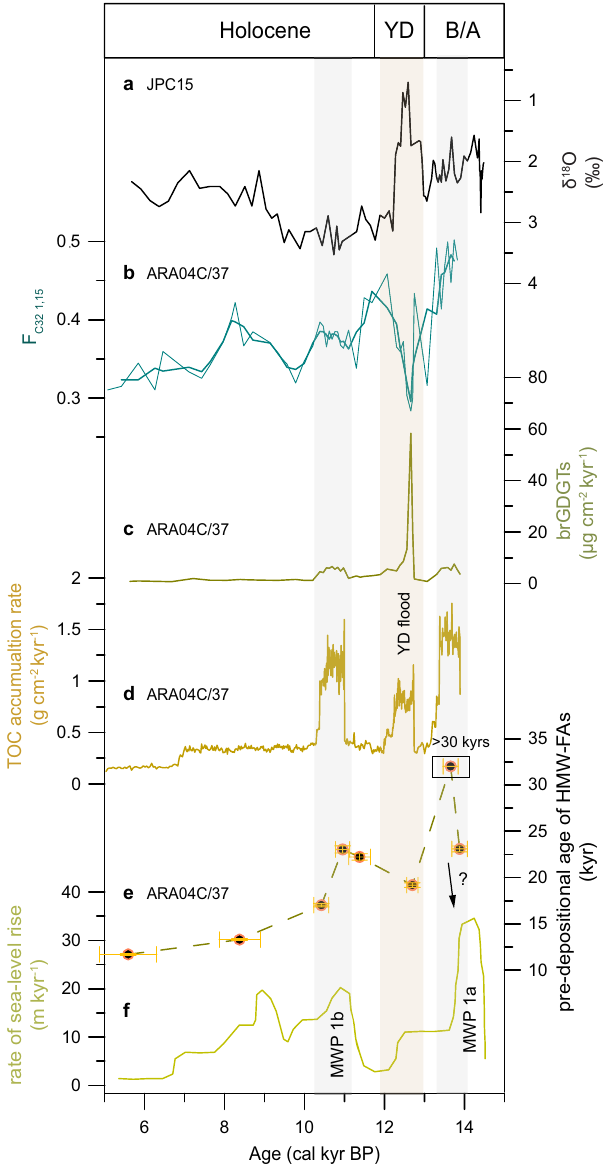
Fig. 3 | Coastal erosion and Younger Dryas fl ood event. a δ 18 O values of Neo- globoquadrinapachyderma incoreJPC15 29 ; b , c F C321,15 (fractionalabundanceofC 32 1,15-diol) and mass accumulation rate of brGDGTs (branched glycerol dialkyl gly- cerol tetraethers) in core ARA04C/37 28 ; d mass accumulation rate of TOC (total organiccarbon) 28 ; e pre-depositionalageofHMW-FAs(highmolecularweightfatty acids). Horizontal error bars represent standard deviation, and vertical error bars representthe propagated uncertainties of the blank-corrected values; f rate ofsea- levelrise 71 .Abbreviationsinthe fi gurearede fi nedasYDYoungerDryas,B/ABølling/ Allerød, MWP meltwater